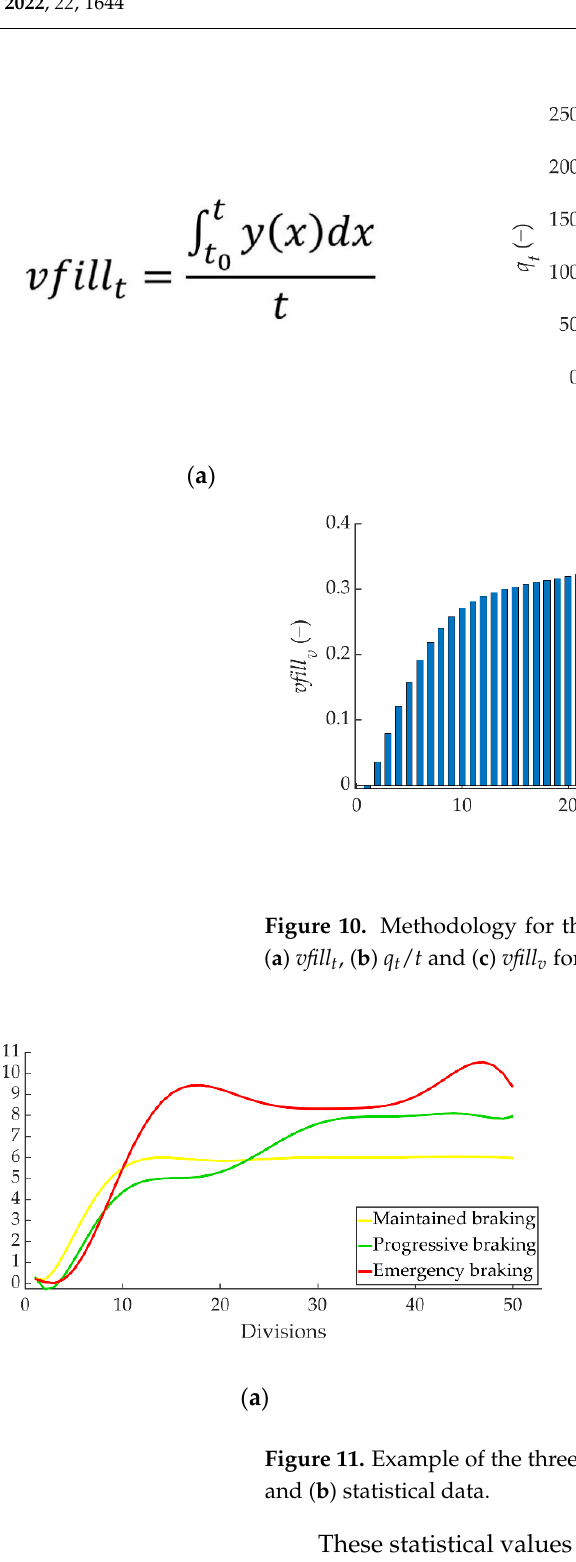
Figure 11. Example of the three types of braking at 80 km/h performed by one of the drivers ( a ) q v and ( b ) statistical data.